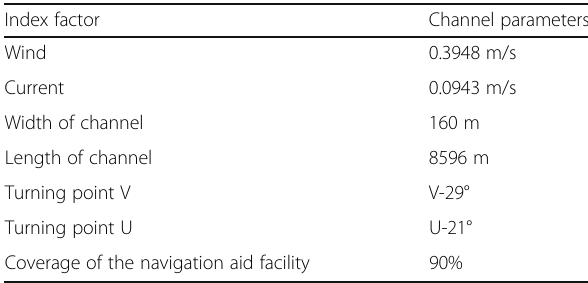
Table 5 Parameters of navigation in the Guangdong inland channel